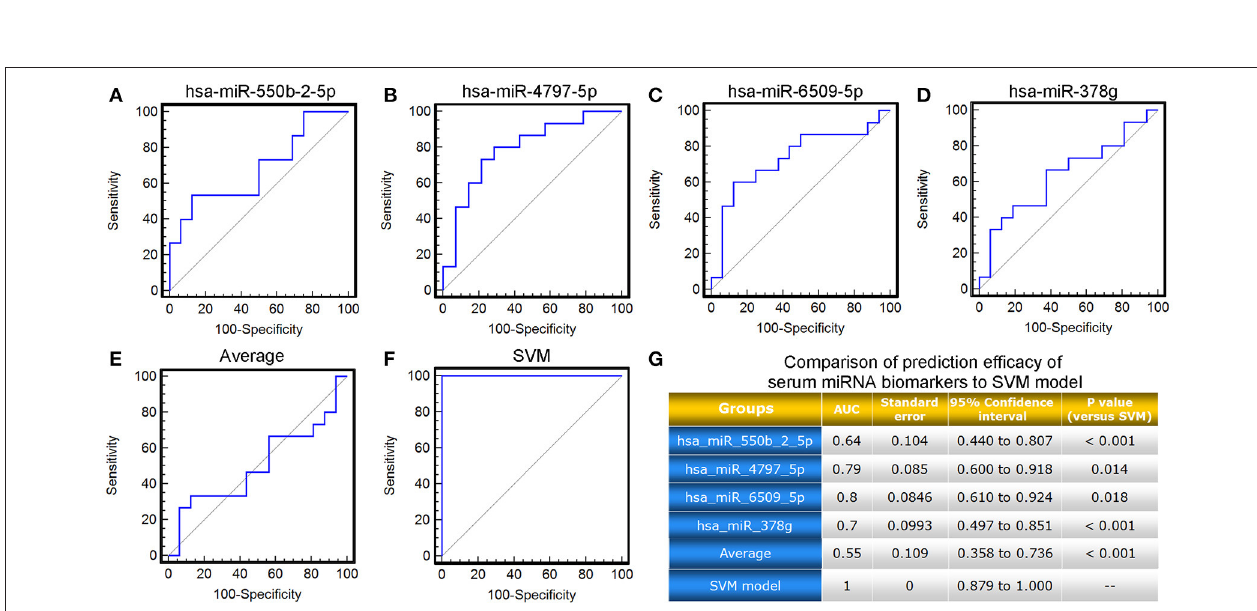
FIGURE 5 | ROC comparison of the four candidate miRNA biomarkers, their average level with the SVM-based model in predicting response to TG tablets . (A–F) ROC curves of hsa-miR-550b-2-5p, hsa-miR-4797-5p, hsa-miR-6509-5p, hsa-miR-378g, the average of their levels, the SVM-based model in predicting response to TG tablets. (G) Statistical significance in ROC comparisons of the four candidate miRNA biomarkers, their average serum level with the SVM-based model in predicting response to TG tablets.